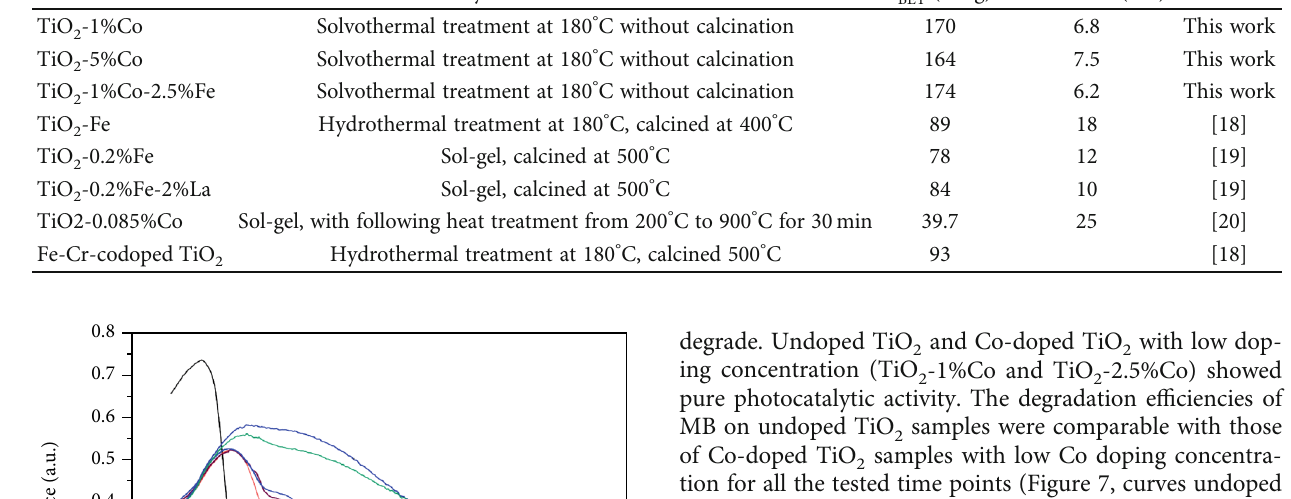
Table 3: Comparison of the BET surface areas of the TiO Materials Synthetic conditions